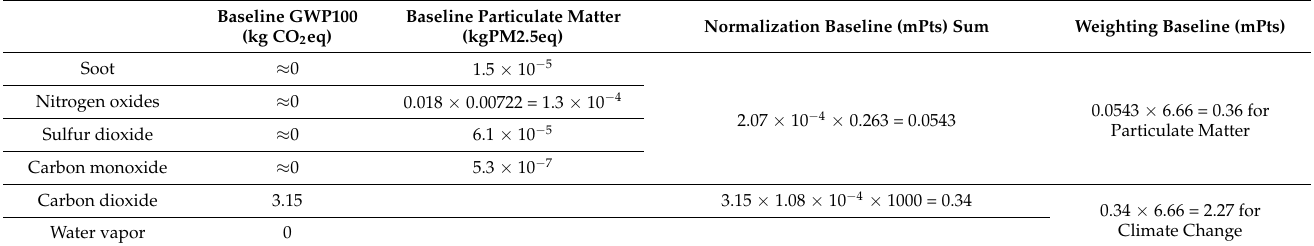
Table 4. Baseline approach ILCD 2011 Mid-point+.